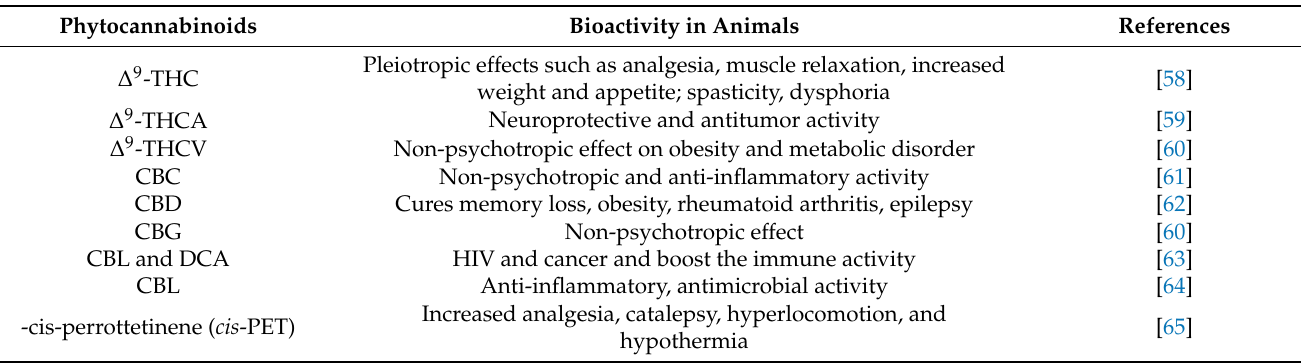
Table 2. Bioactivity and effect of different phytocannabinoids in